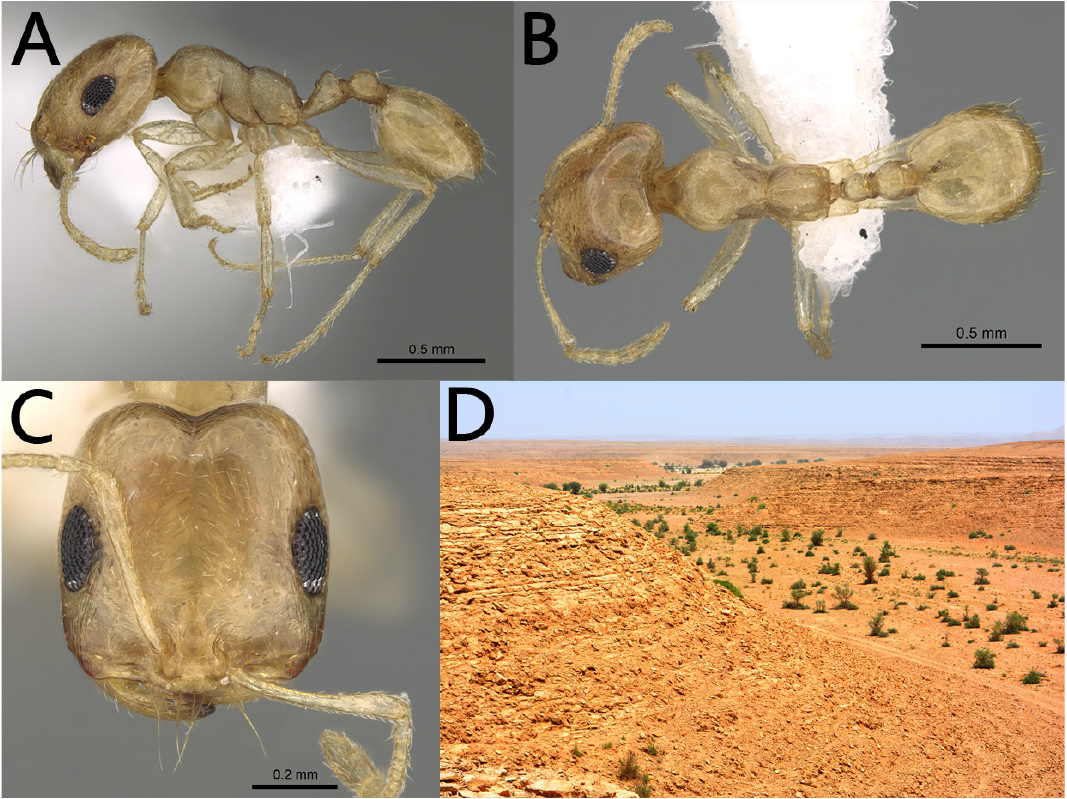
Fig. 13. Trichomyrmex shakeri sp. nov., paratype, worker (CASENT0922068). A . Body in profile. B . Body in dorsal view. C . Head in full-face view (photos: Michele Esposito). D . Type locality (photo: A. Shams